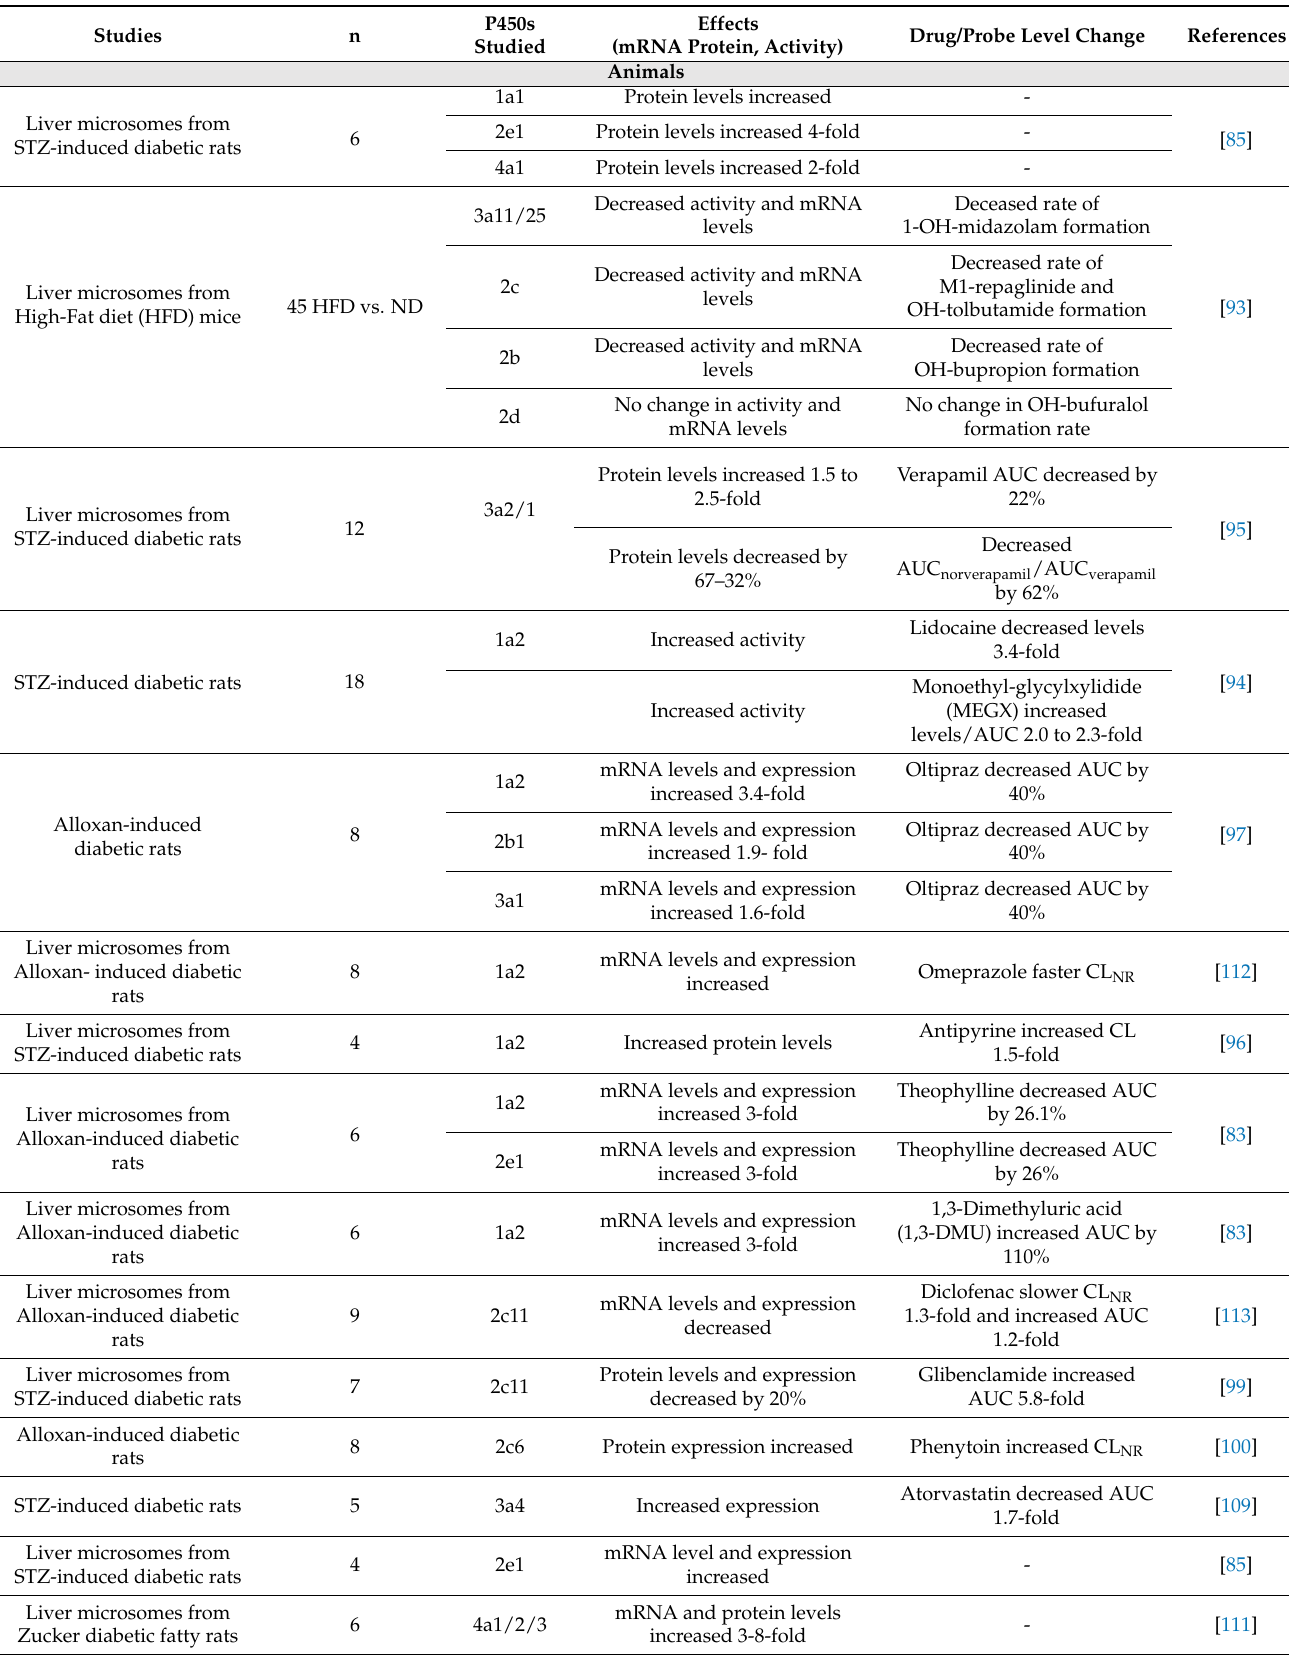
Table 1. Effect of T2DM in multiple models on the expression and activity of several P450